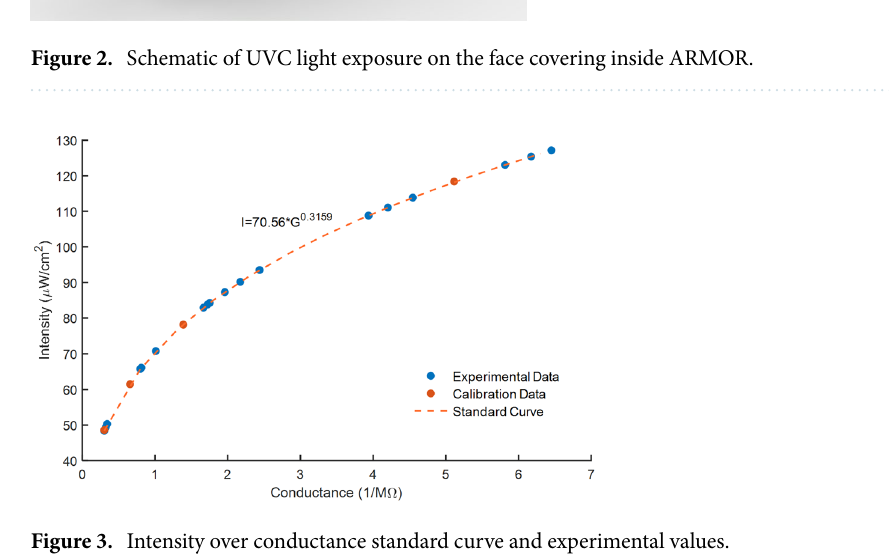
Figure 3. Intensity over conductance standard curve and experimental